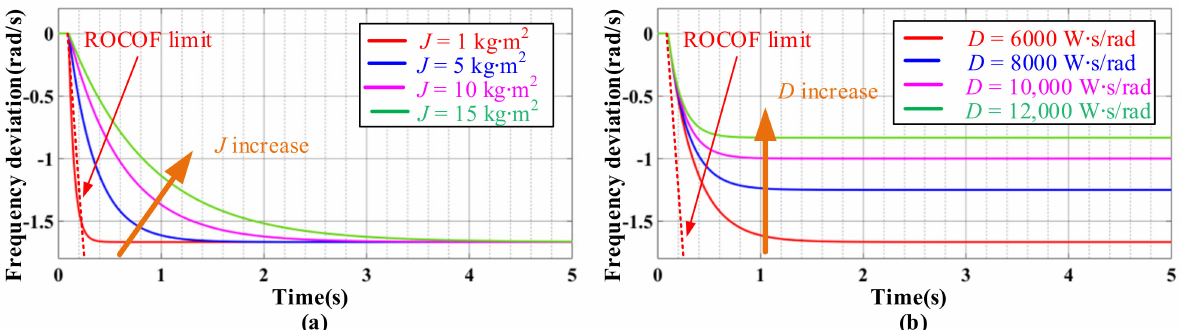
Figure 8. Frequency response curves under different J in SA mode. ( a ) different J ( b ) different D